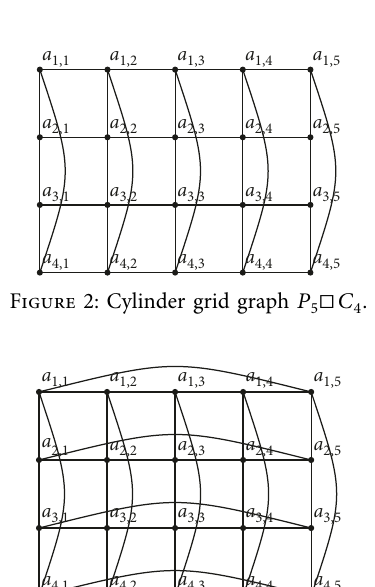
Figure 1: Grid graph P